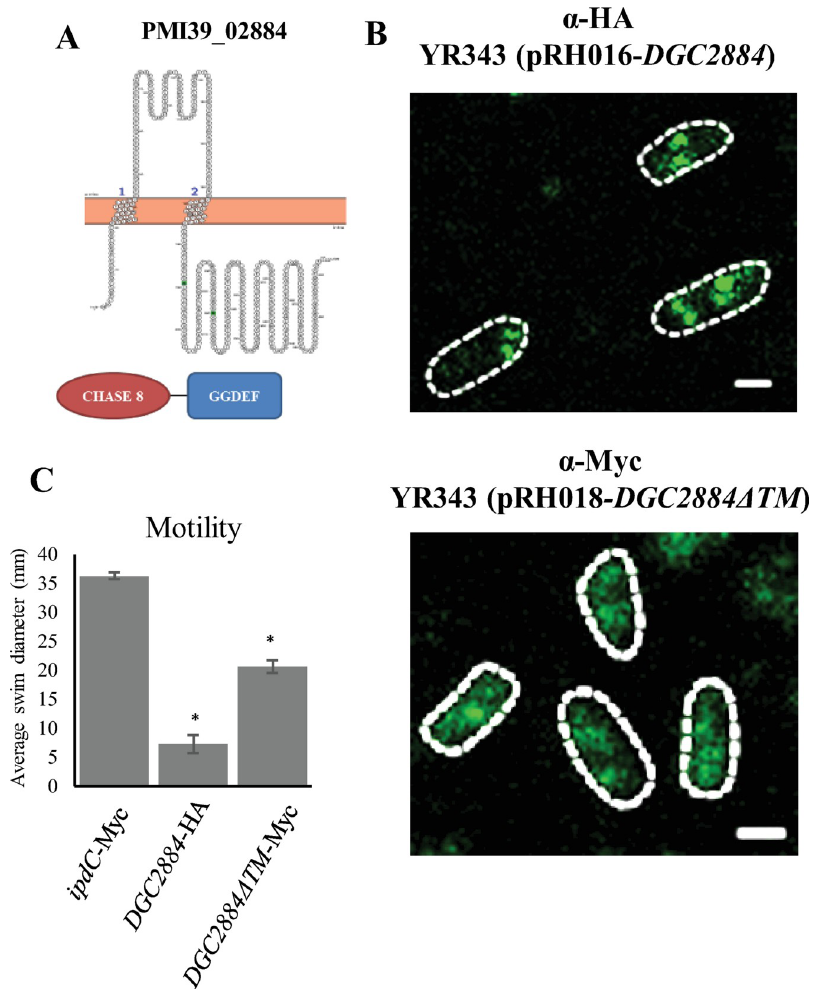
Fig 3. Localization of wild type DGC2884 and DGC2884 Δ TM expressed in a wild type background using immunofluorescence assays. (A) Predicted topological structure of DGC2884 using Protter (top) and domain organization based on pfam analysis (bottom). (B) HA- tagged DGC2884 and Myc-tagged DGC2884 Δ TM were detected using immunofluorescence assays and imaged using confocal microscopy. Individual cells are outlined in a white dashed line. Scale bars represent 1 μ m. (C) Motility plate assays demonstrating functionality of tagged constructs, including an ipdC negative control. Data represent three biological replicates and at least two independent experiments. ( � ) indicate statistically significant differences (p < 0.001) as measured by the student’s t-test. ANOVA analysis also showed statistically significant differences between samples (p �